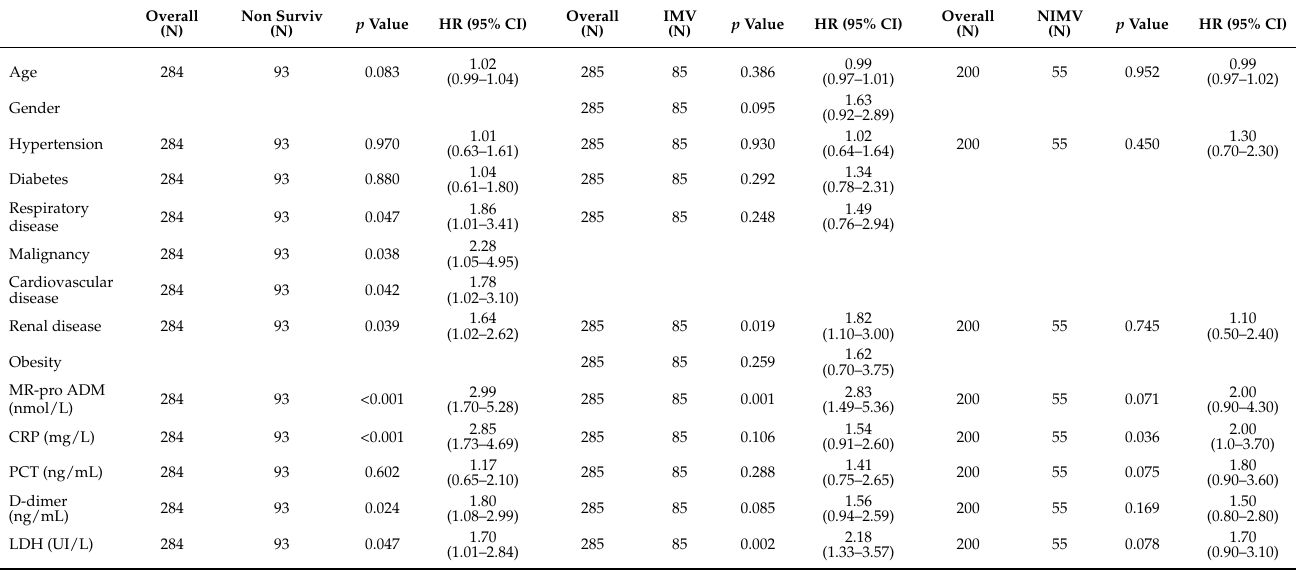
Table 4. Multivariate Cox Regression Analysis pooling together biomarkers and clinical characteristics for the primary (survivors) and the secondary (IMV, NIMV) outcomes. Multivariate Cox Regression Analysis for the prediction of 45-day mortality and 28-day